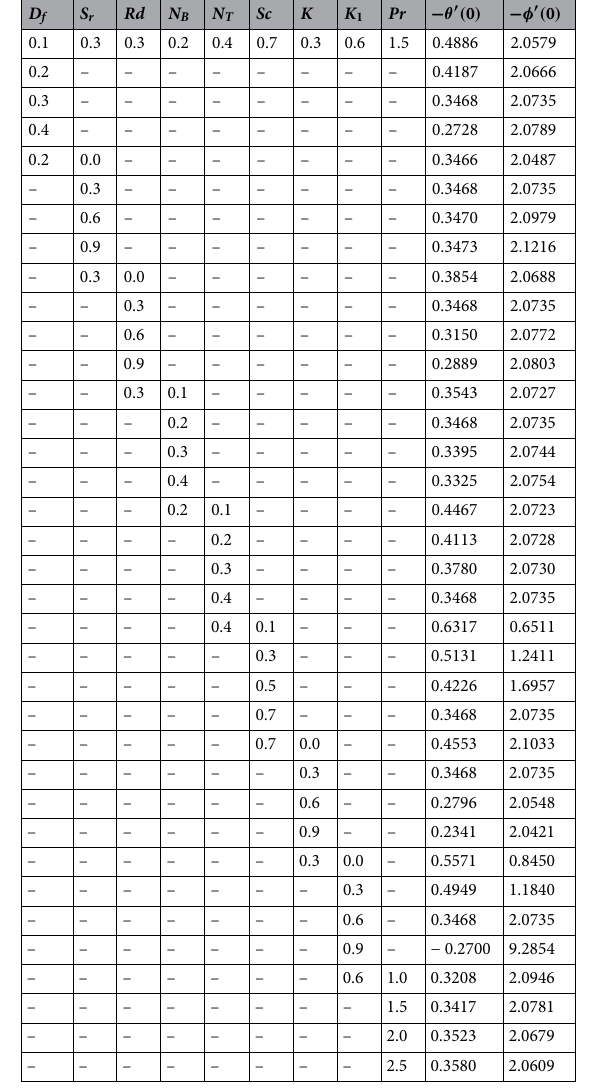
Table 2. Numerical results of − θ ′ ( 0 ) and − φ ′ ( 0 ) for different values of physicalparameters.